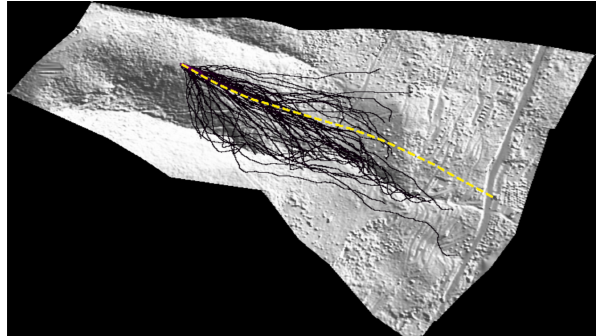
Figure 15. Three-dimensional trajectory analysis (from Rocky- for3D analysis). The yellow line shows the actual trajectory. Black lines show the simulated trajectory.